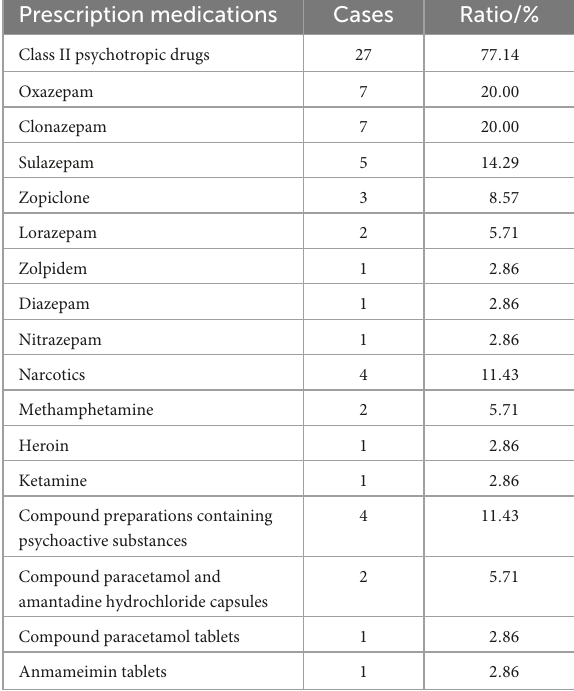
TABLE 2 Numbers of reported cases of PMA under the new PMA monitoring model in 2021.